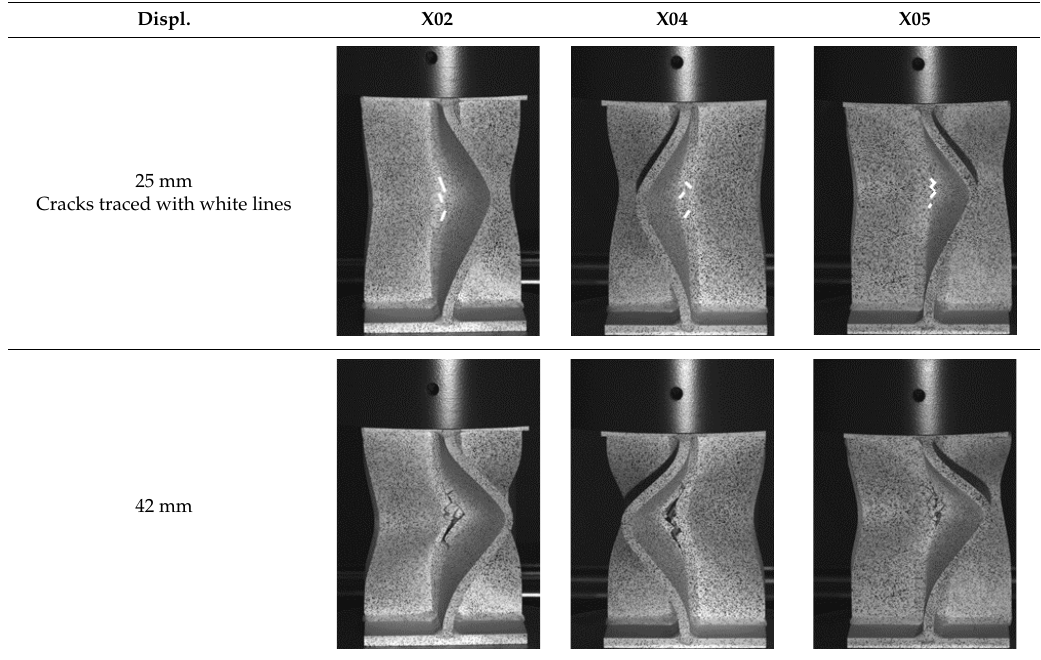
Table 2. Deformation of X-profiles (10-mm plate thickness) and crack growth within axial compression tests at different global displacements (data from [27]). Displ. X02 X04 X05